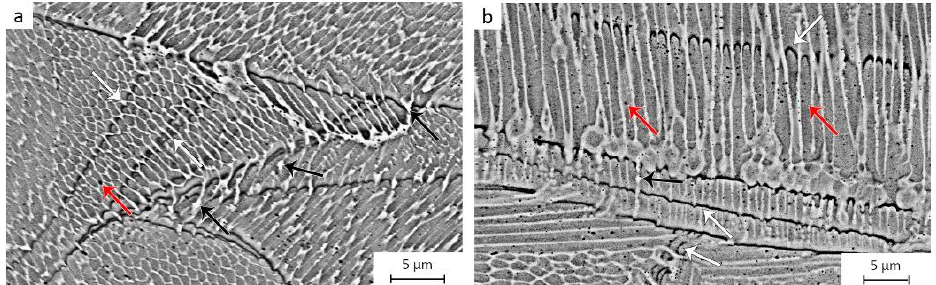
Figure 13. Backscattered SEM images of as-built microstructures showing cellular substructure in xz plane of specimens: ( a ) Laser power 100 W and ( b ) Laser power 200 W. White arrows indicate segregation traces at cells tips (solute banding lines), black arrows—eutectic δ-ferrite, and red arrows—nanoinclusions. Reprinted with permission from [14], Copyright 2018 Elsevier.